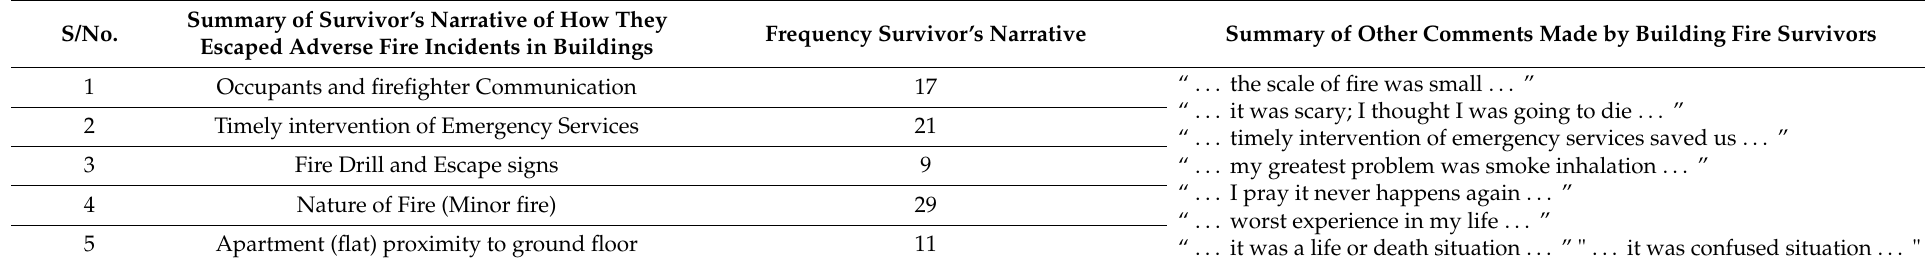
Table 2. Summary of the accounts of fire survivors’ who adopted a stay-put strategy.